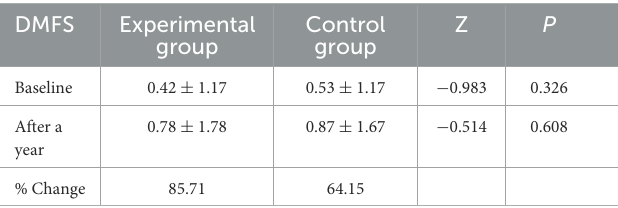
TABLE 8 DMFS of first permanent molars at baseline and after a year (mean ±